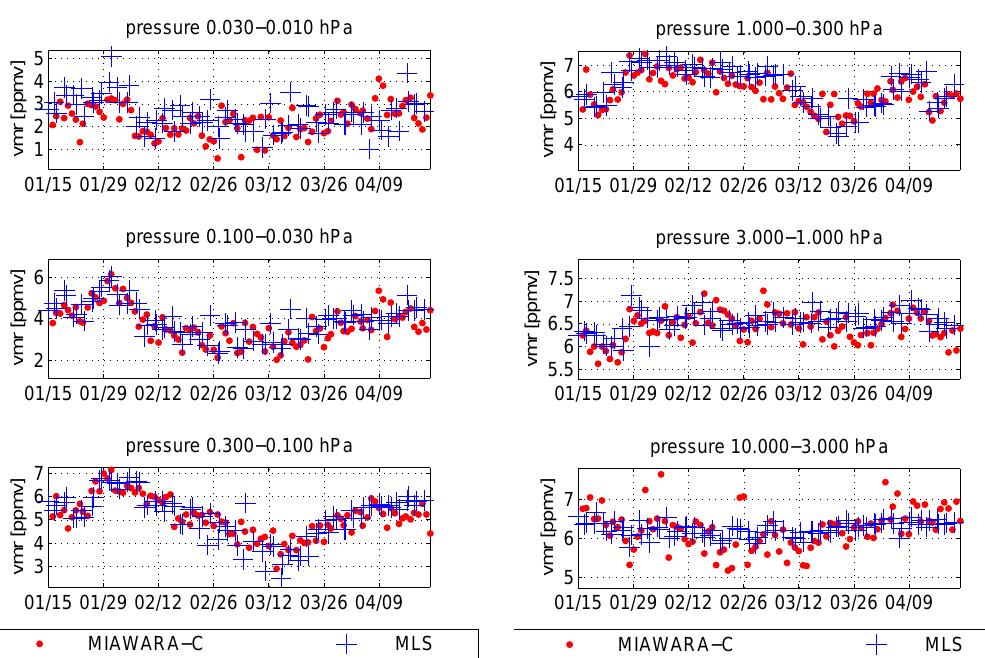
Fig. 14. Timeseries of middle atmospheric H 2 O for 6 pressure ranges between 10 and 0.01hPa as observed by MIAWARA-C and MLS during the Lapbiat campaign. A mean value of the H 2 O-vmr within the pressure ranges indicated is used to account for the different altitude resolutions of the two instruments.